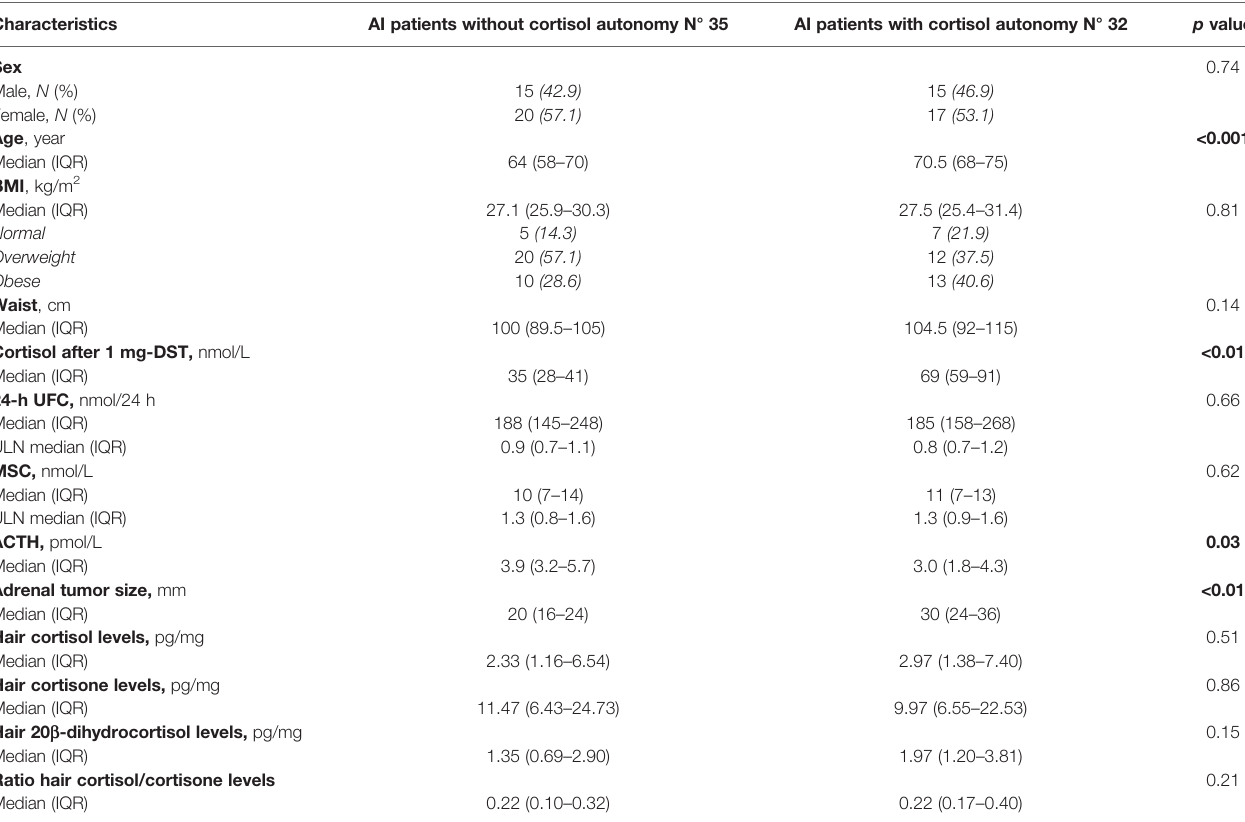
TABLE 4 | Comparison of baseline characteristics of AI patients, according to the presence of cortisol autonomy.